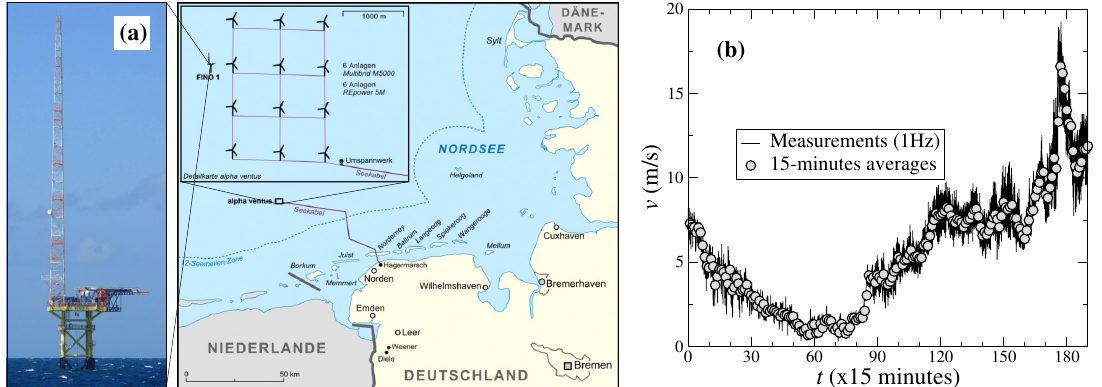
Figure 1. ( a ) FINO1 platform, located at Alpha Ventus wind farm at Borkum West in the North Sea (54.3 o N–6.5 o W). Source: c (cid:13) Forschungs- und Entwicklungszentrum Fachhochschule Kiel GmbH (Kiel, Germany). ( b ) Illustration of the series of wind speed measurements (solid line) taken at the height of 100 m with a sampling frequency of 1 Hz. Symbols indicate 15 min average analysed in this